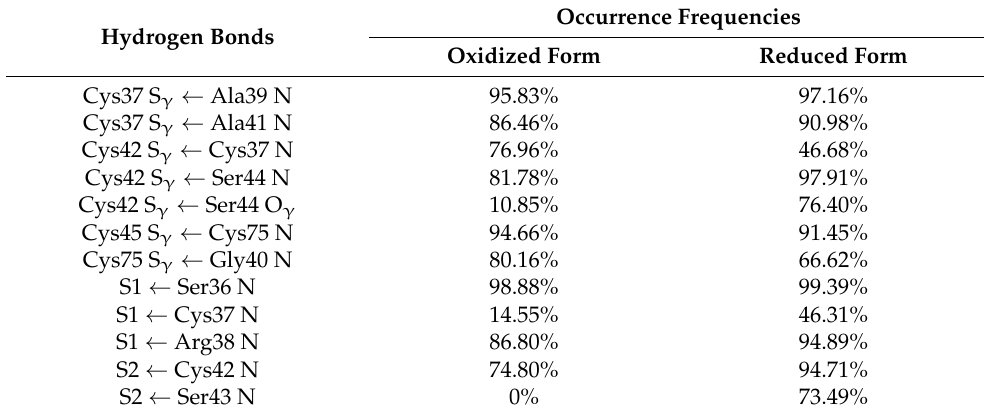
Figure 7. Distribution of the number of [NH…S] and [OH…S] hydrogen bonds. The number of hy- drogen bonds in the oxidized and reduced forms are represented in blue and red, respectively.